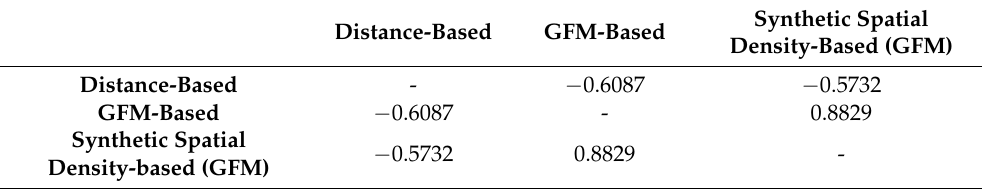
Table 6. Average correlation indices of different kinds of locational and neighborhood